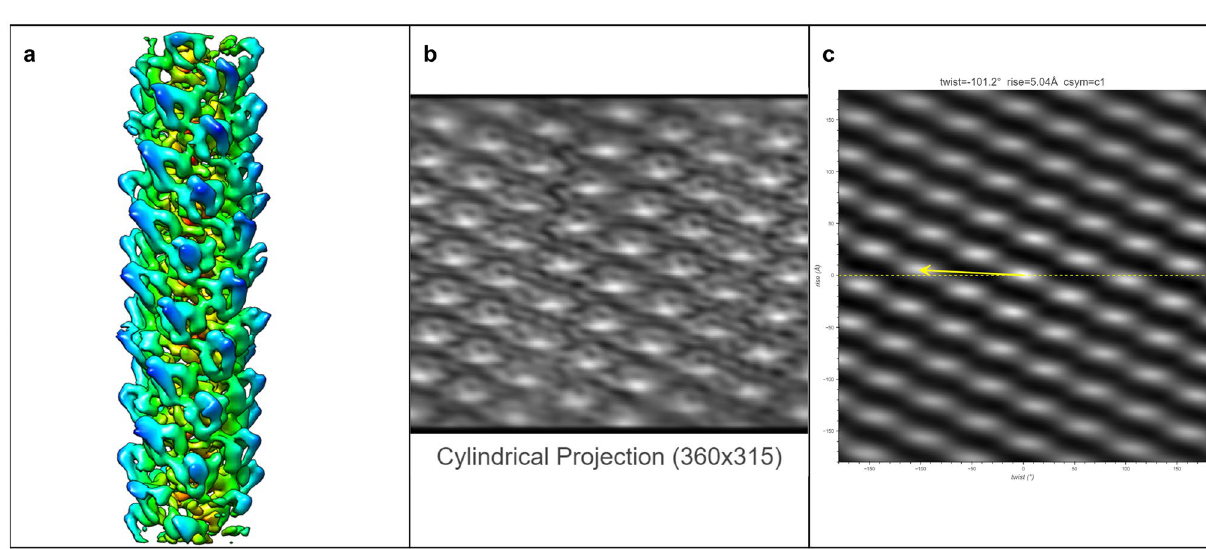
Figure 5. The surface view of the asymmetric reconstruction ( a ), the cylindrical projection ( b ), and the 2D lattice ( c ) with the HI3D outputted helical rise and twist and C-sym of the TMV dataset (EMPIAR-1022). The surface view was generated with UCSF Chimera 18 .